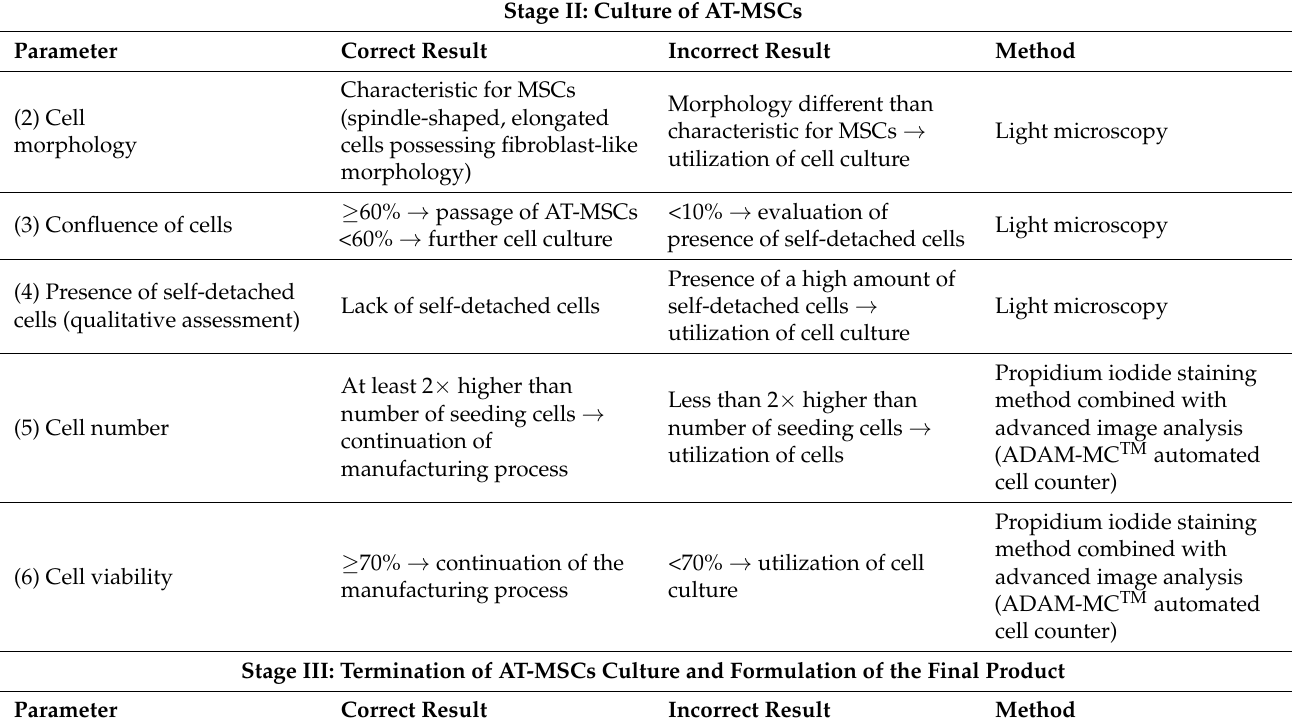
Table 1. Cont . Stage II: Culture of